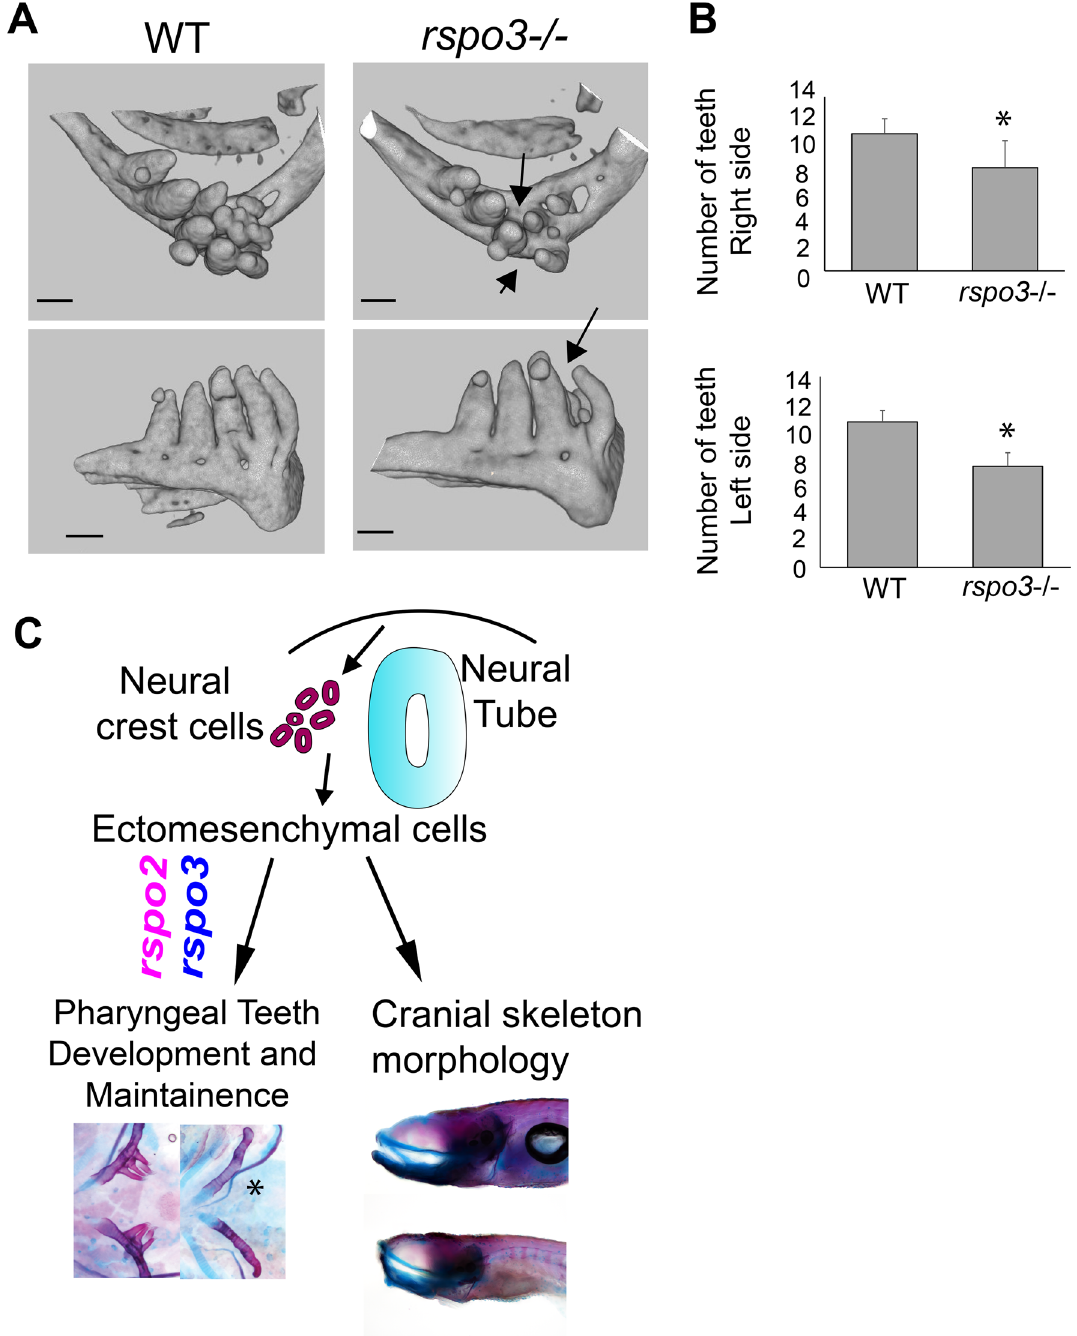
Figure 8. Adult rspo3 mutant zebrafish have reduced teeth number. ( A ) Micro-CT of 180 dpf zebrafish reveals that the adult rspo3 −/− animals exhibit decreased tooth number with several sockets missing teeth that are present in the wild-type. ( B ) rspo3 −/− have significantly fewer teeth than wild-type on both right and left sides. N = 9.7. *p < 0.05. ( C ) Summary diagram illustrating that rspo2 and rspo3 both regulate pharyngeal tooth development as well as have roles in morphogenesis of the craniofacial